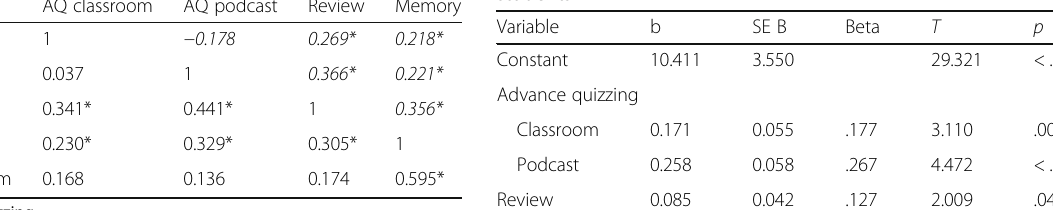
Table 3 Regression analysis predicting “ Introduction to Memory ” exam performance from advance quizzing and review in